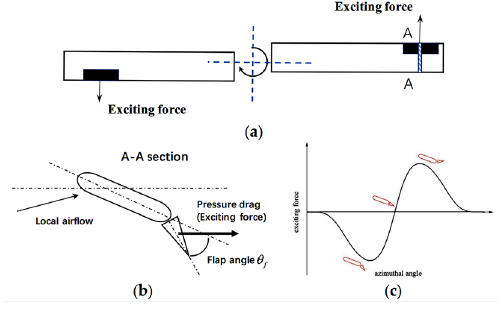
Figure 10. Schematic of experimental setup [52].